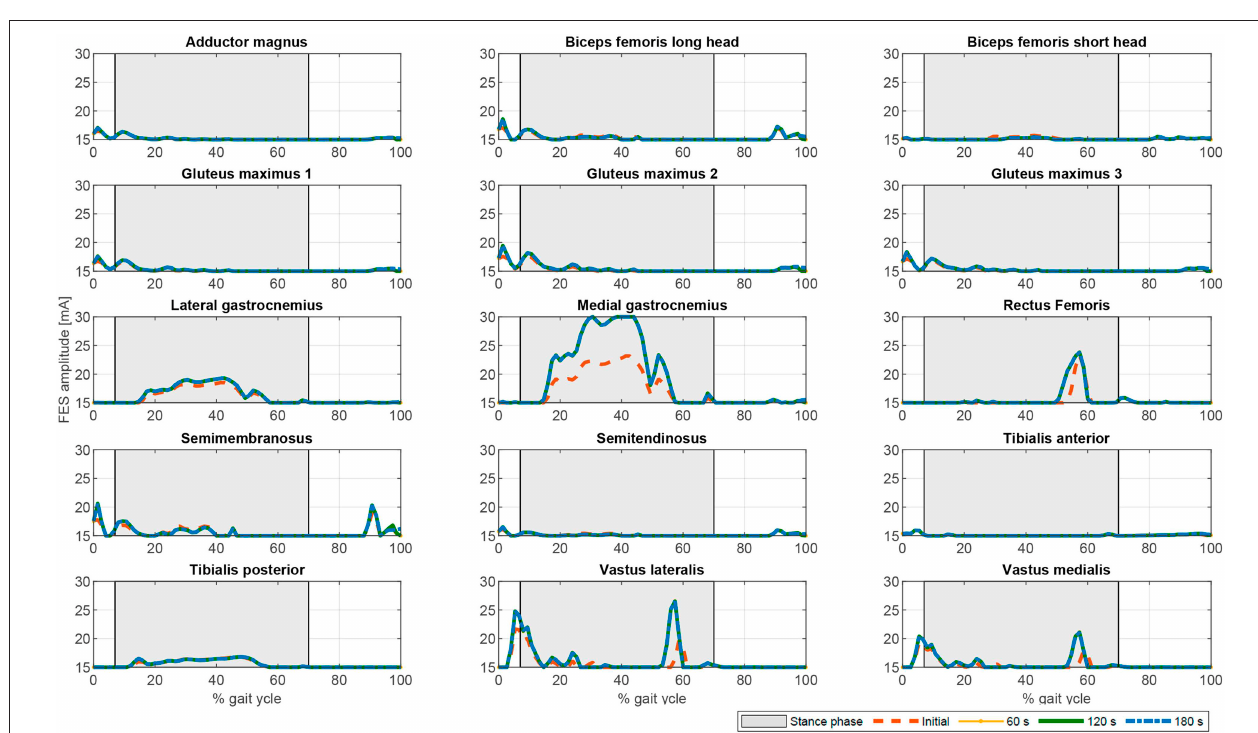
FIGURE 7 | Evolution of the FES profiles for the proposed muscles using the fatigue factor proposed by Riener et al. (1996) for function F 1 . Dashed orange line: Initial FES profile. Dotted yellow line: FES profile at 60 s. Solid green line: FES profile at 120 s. Dash-dotted blue line: FES profile at 180 s.